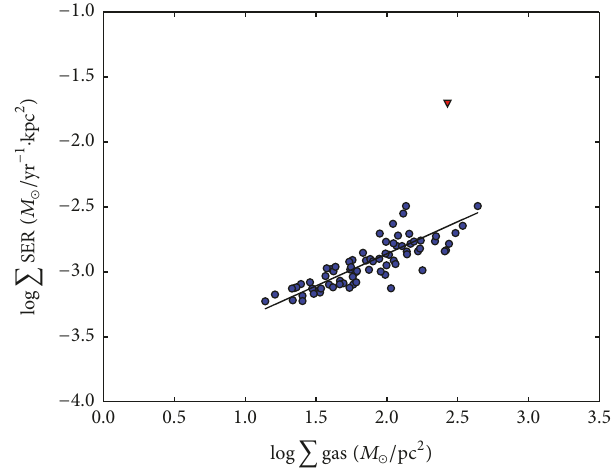
Figure 2: ALMA 12 CO ( 𝐽 = 2-1) velocity dispersion images of Centaurus A (NGC 5128). Figure 3: Relation between the surface density of molecular hydrogen ∑ H 2 andsurfacedensityofstarformationrate ∑ SFR.The solid line represents the linear square fit